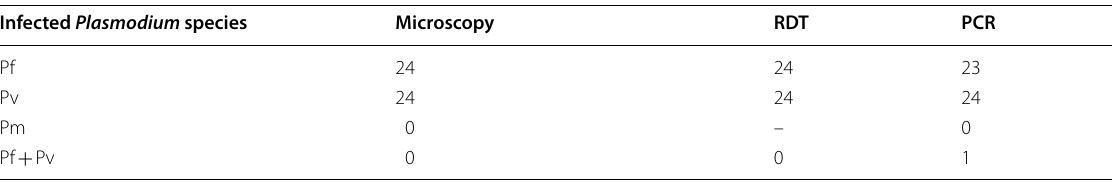
Pv: mixed infection with Pf and +